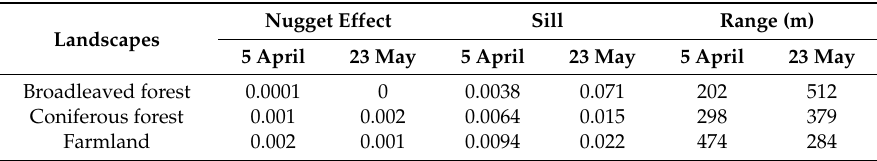
Table 5. Parameters of variogram models in NDVI experimental variograms for three contrasting landscapes, including broadleaved forest, coniferous forest, and